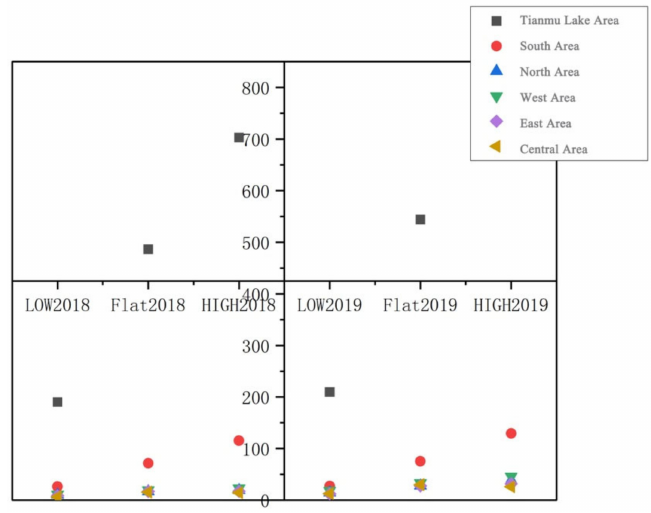
Figure 12. Off–flat–peak season distribution characteristics of regional tourism flows.